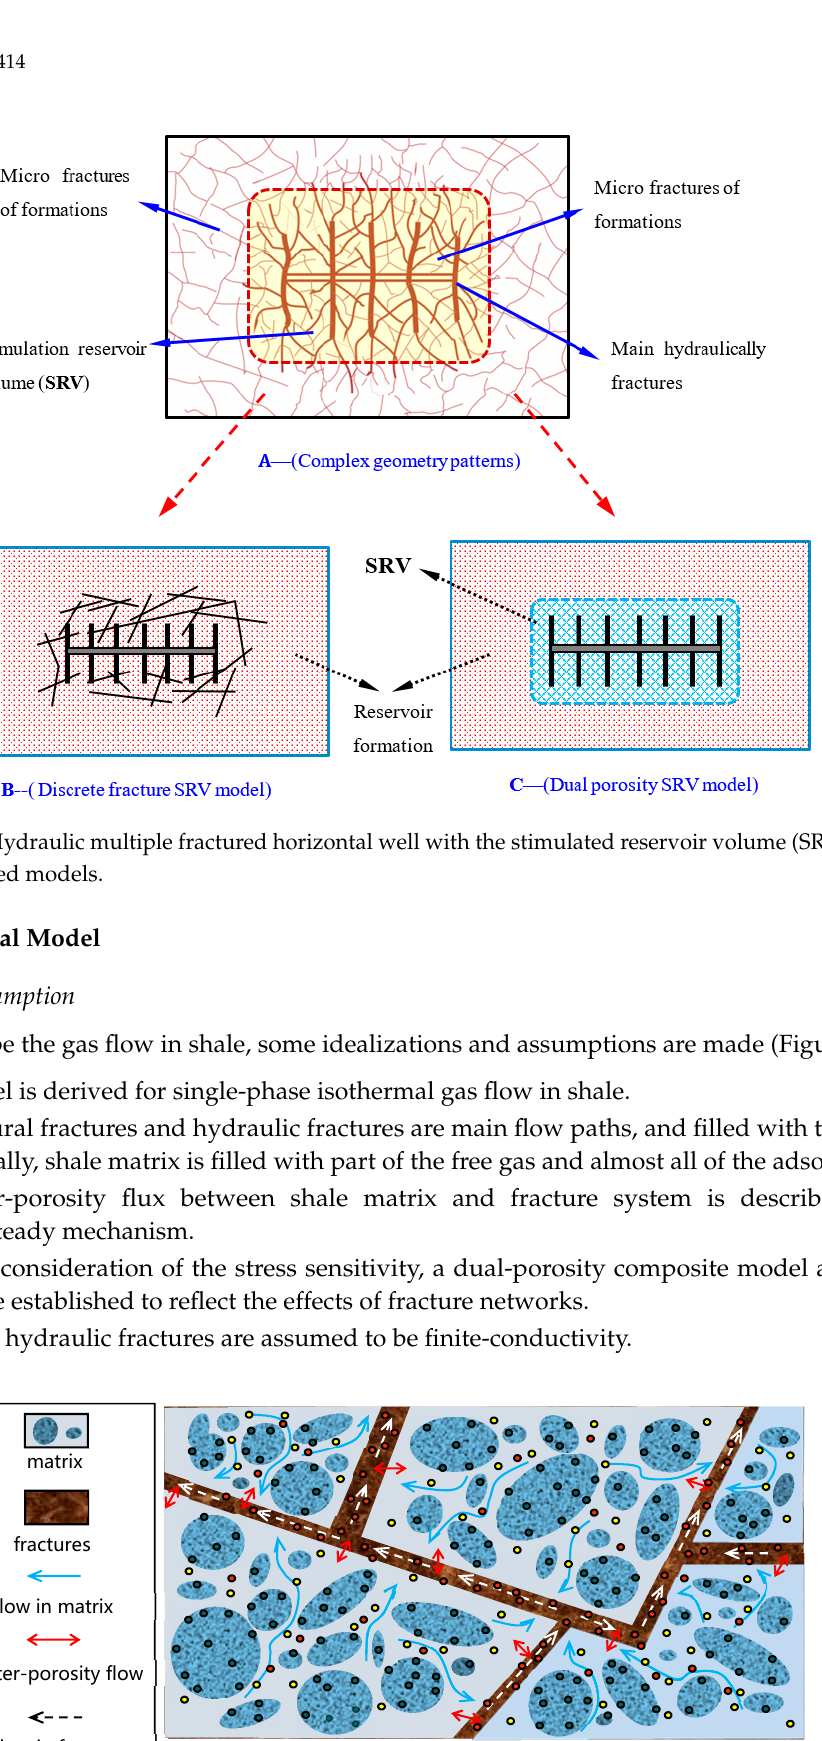
Figure 4. The pore distributions curves of Longmaxi formation Sichuan basin. 0.00 0.020.040.060.08 1.0E-01